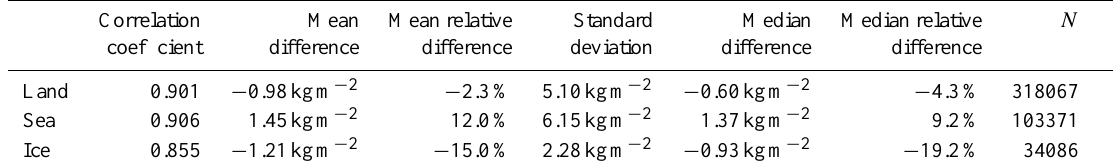
Table 2. Statistics of comparisons between GOME-2A with radiosondes over different surface types.